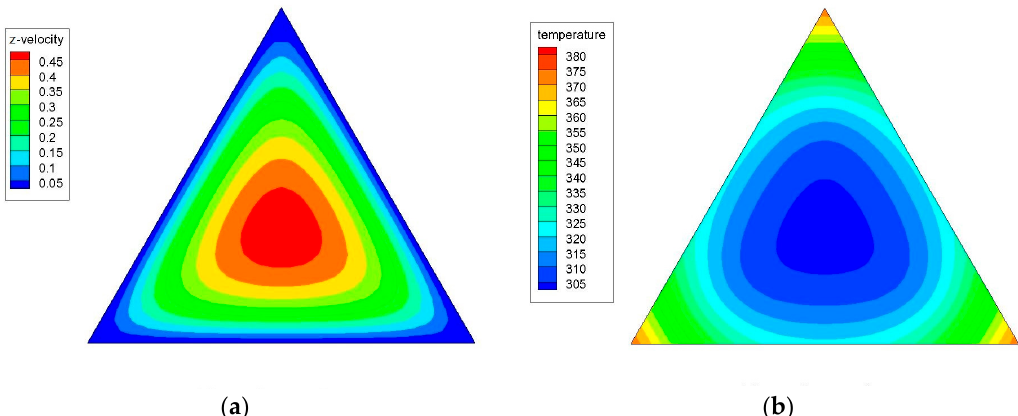
Figure 6. ( a ) Axial velocity and ( b ) temperature contours in a triangular cross-sectional duct with a hydraulic diameter ( D h ) of 4.2 mm at z / D h = 200 and Re = 1100 for Al 2 O 3 /water nanofluid with 0.5% nanoparticle volume concentration.